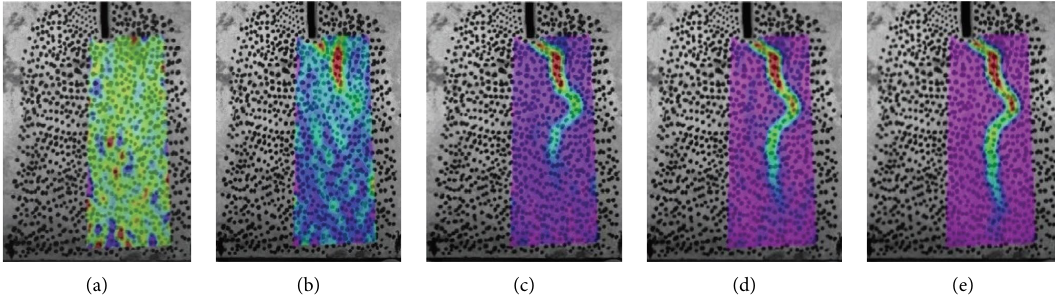
Figure 9: Te strain feld cloud picture at diferent loading stages. (a) P